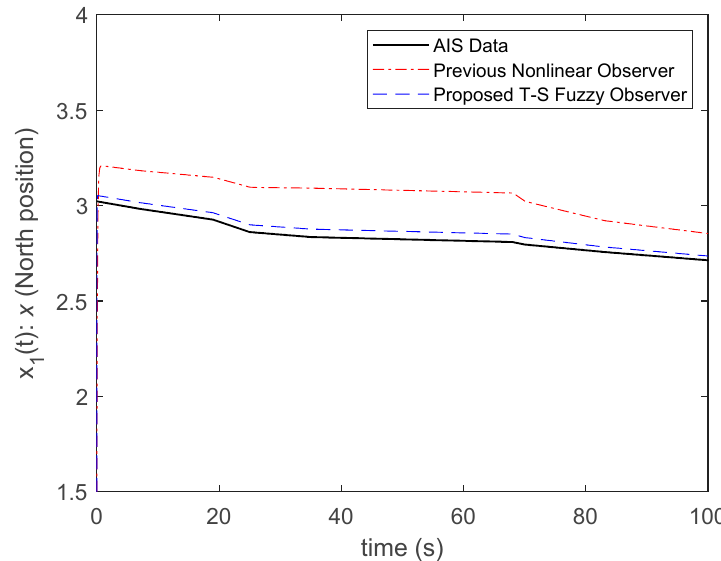
( ) x t with [26]. x t with [26]. 1 1